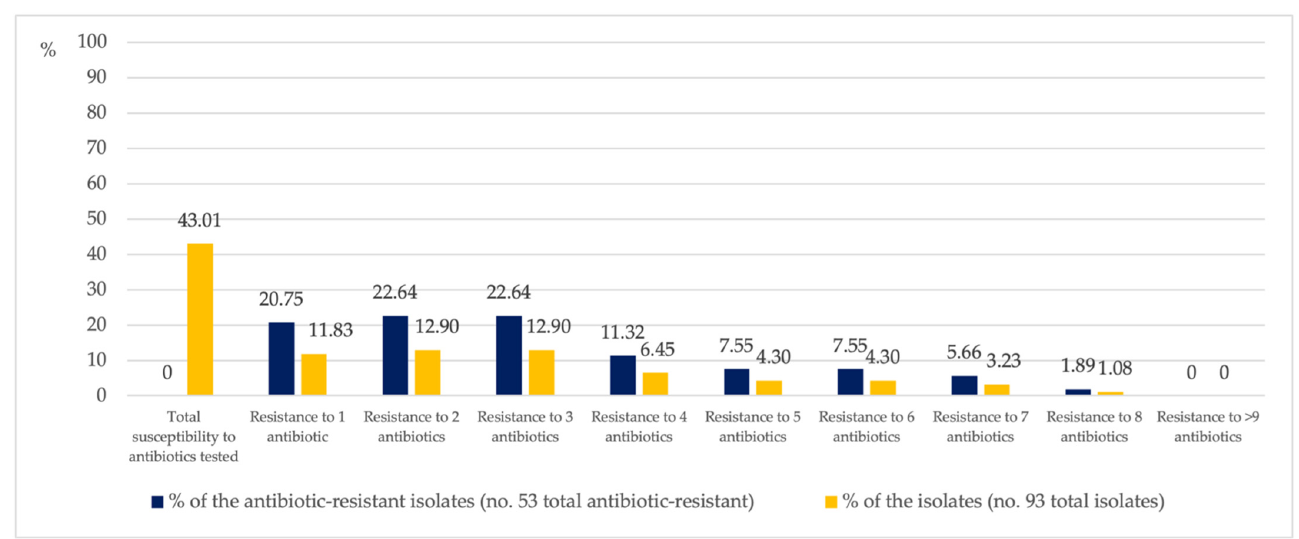
Figure 2. Percentage of P. aeruginosa isolates simultaneously resistant to between one and eight antibiotics. The percentage of antibiotic resistant strains has changed over the years, but in a discontinuous way (Figure S1, Supplementary Materials). However, based on the observed data, the probability of occurrence of resistant strains increases by 1.2 over the years (OR = 1.20 [95% CI, 1.01–1.43], p = 0.0351). Table 2 shows the antibiotic-resistant characteristics relative to the P. aeruginosa isolates. Table 2. P. aeruginosa isolates resistant (R) to the various antibiotics